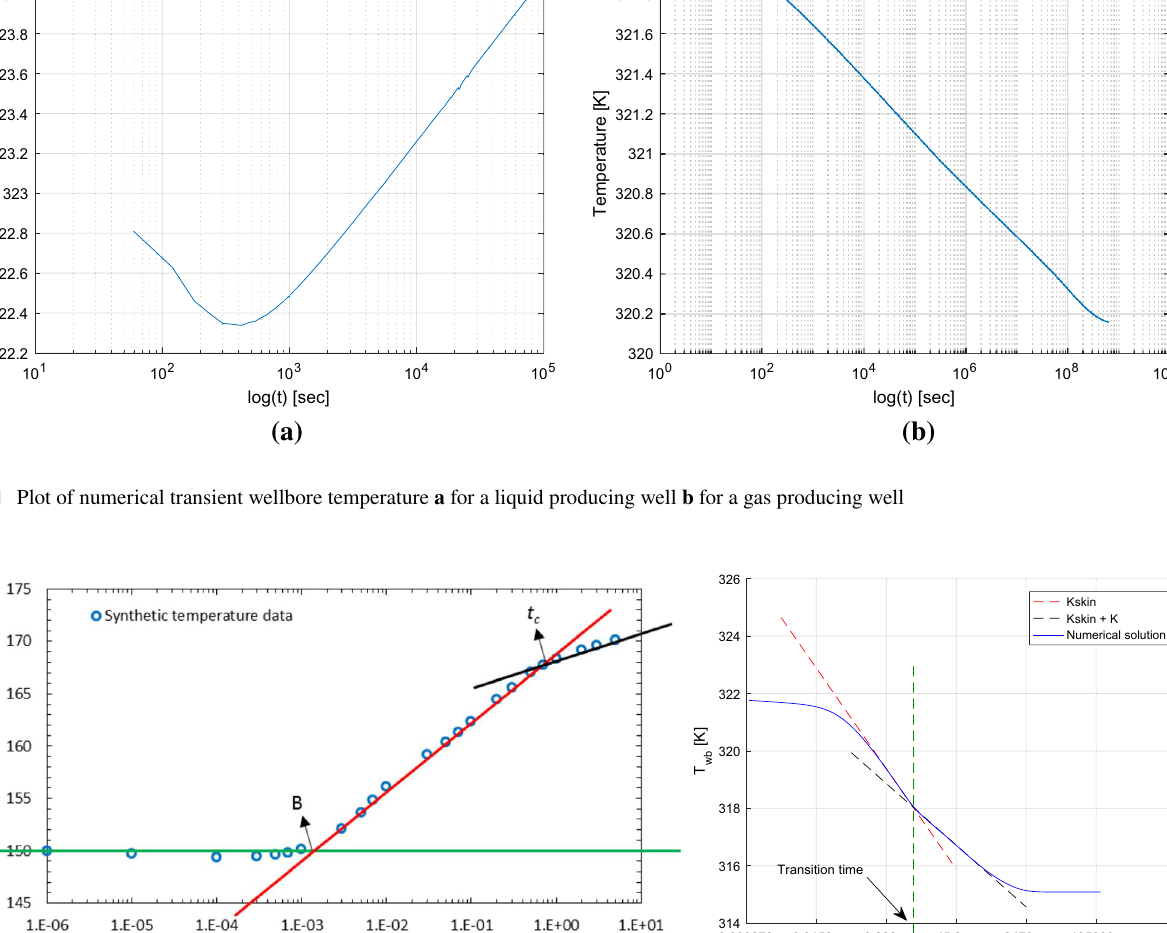
a gas producing well, the red dashed line is the slope for the damaged region, while the black solid line is the slope for the virgin formation, Dada et al.